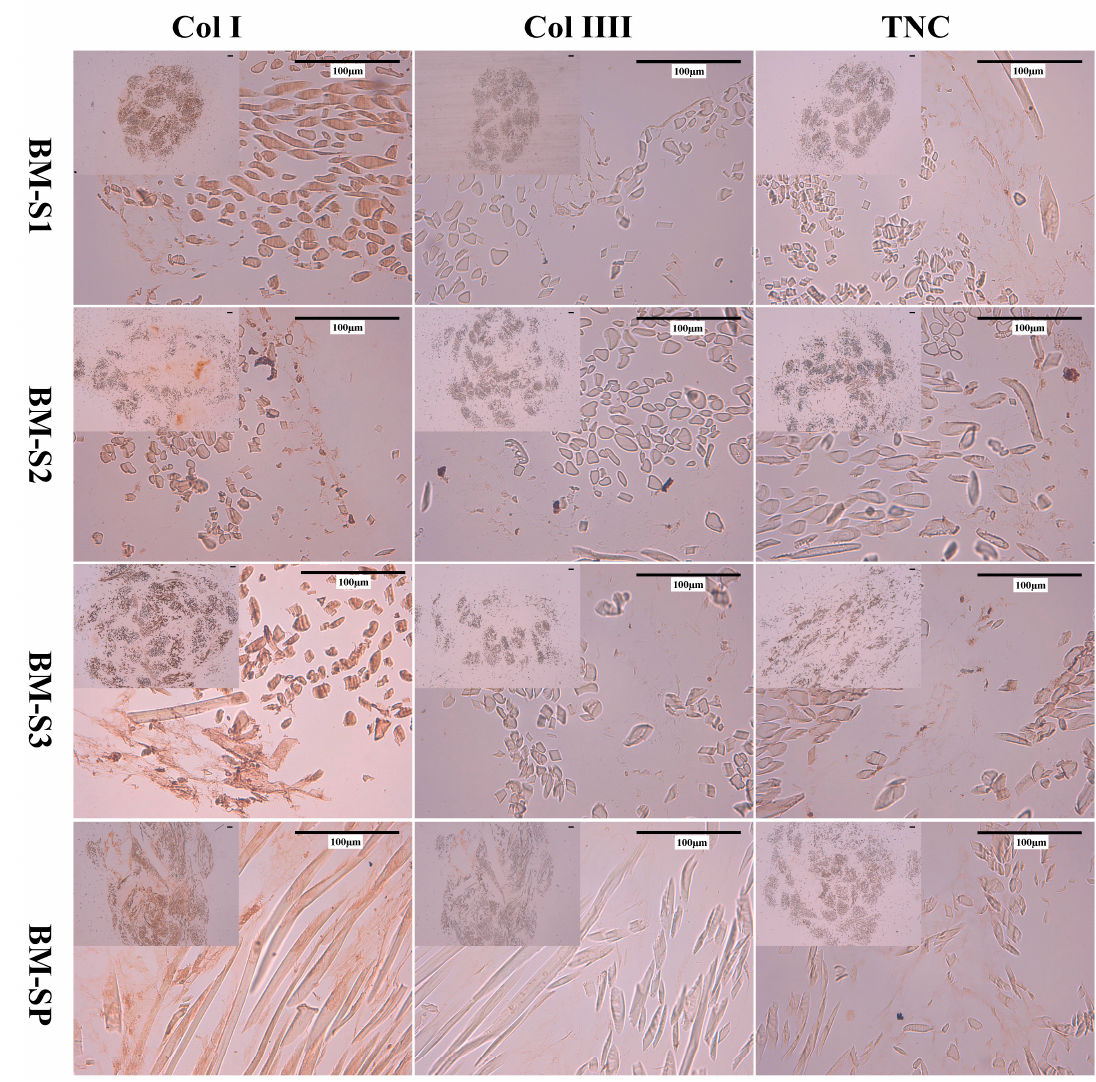
Figure 6. IHC images of BM-MSCs on silk and silk/PLCL scaffolds. (S1: one-layer silk scaffold; S2: two-layer silk scaffold; S3: three-layer silk scaffold; SP: silk/PLCL composite scaffold; Col I: collagen I; Col III: collagen III; TNC: tenascin-c).